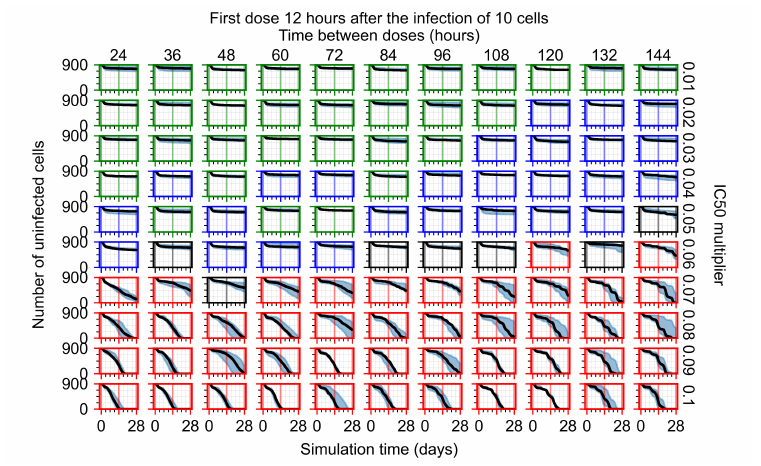
Figure A84. Uninfected population.